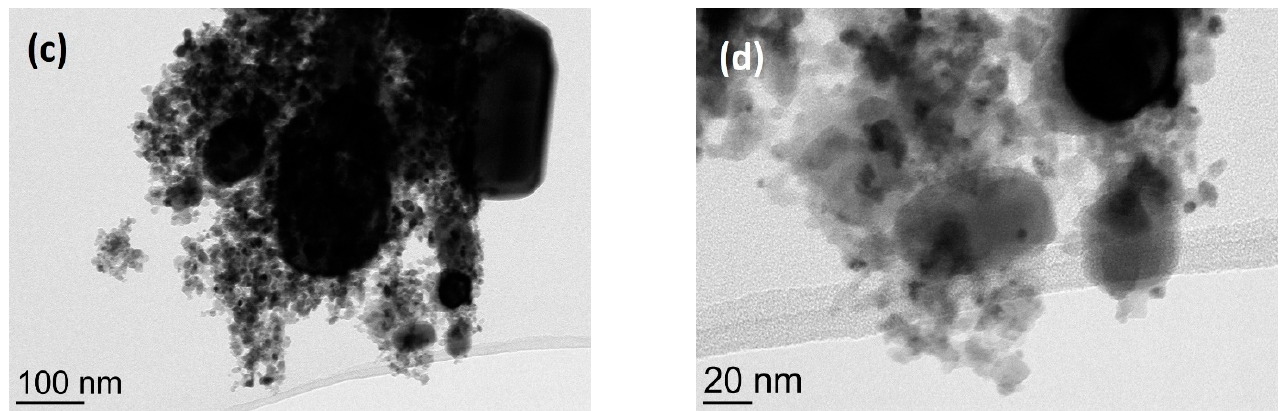
Figure 5. TEM images of ( a ) NiTe after 8 h milling time, ( b ) NiTe 2 after 12 h milling time, and ( c , d ) Ni 2 Te 3 after 12 h milling time.